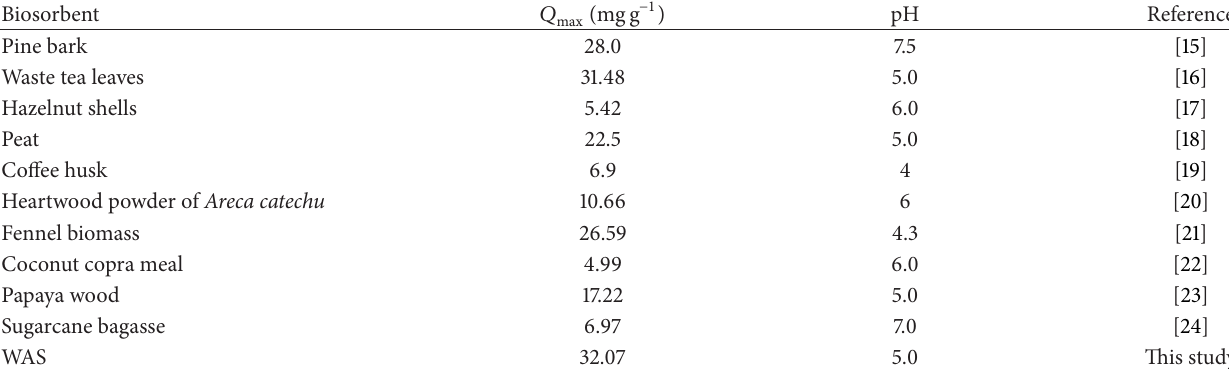
Table 4: Comparison of maximum adsorption capacities ( 𝑄 max ) of Cd(II) with various biosorbents.